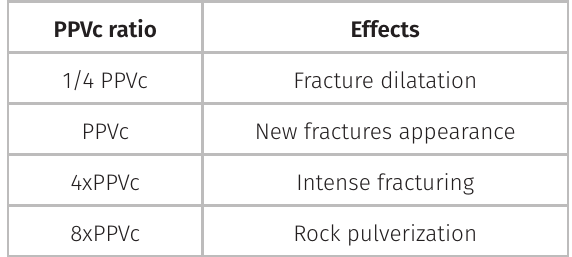
Table IV. Relationship between damage and